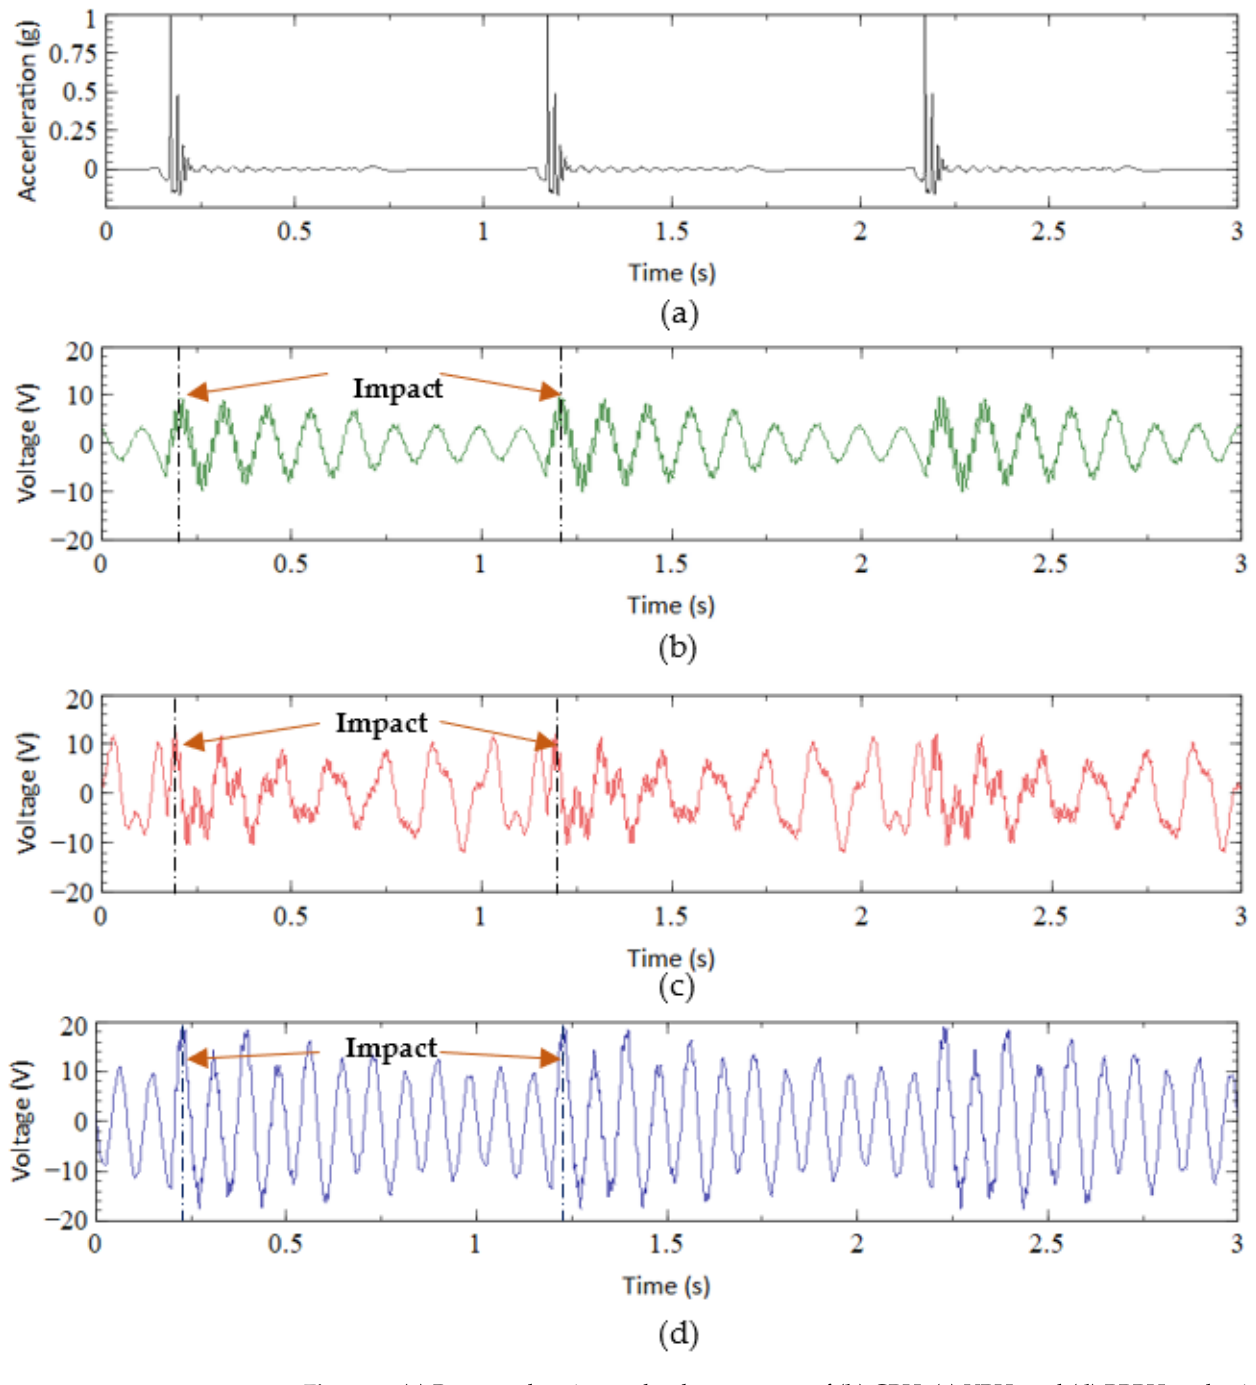
Figure 6. ( a ) Base acceleration and voltage output of ( b ) CBH, ( c ) VBH, and ( d ) BBBH under 1 Hz and 1 g acceleration. and 1 g